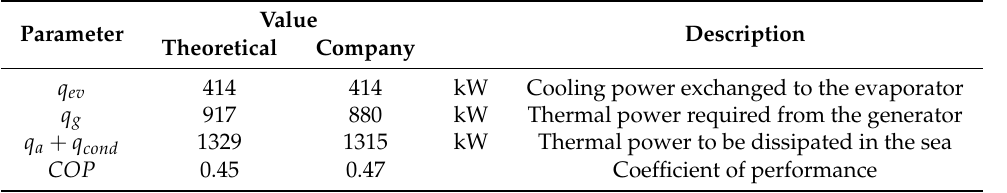
Table 3. Theoretical and real plant